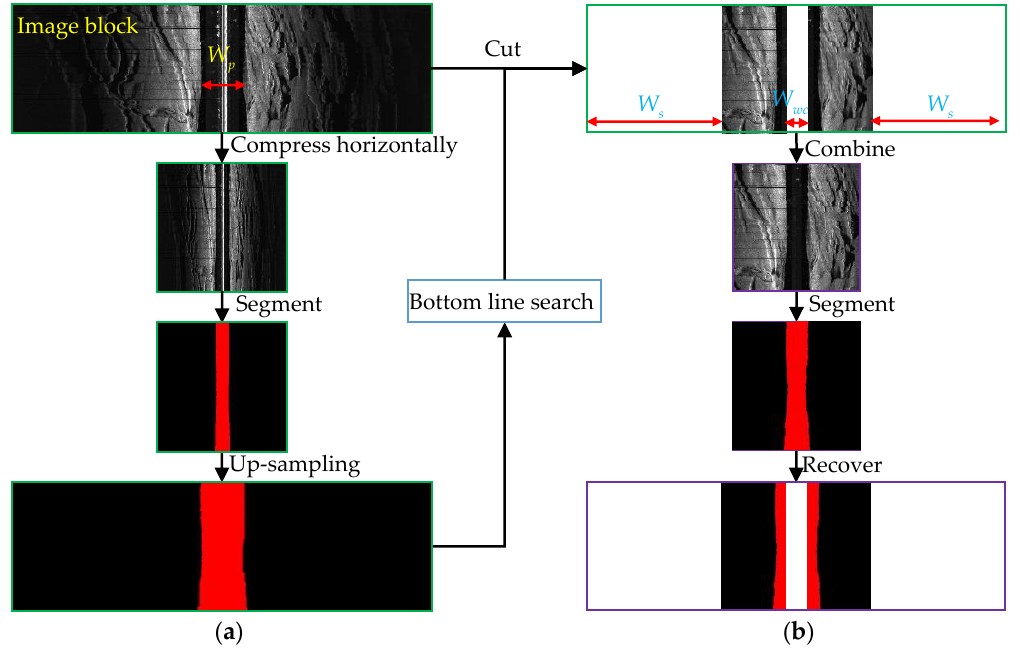
Figure 7. Sea bottom line extraction process.